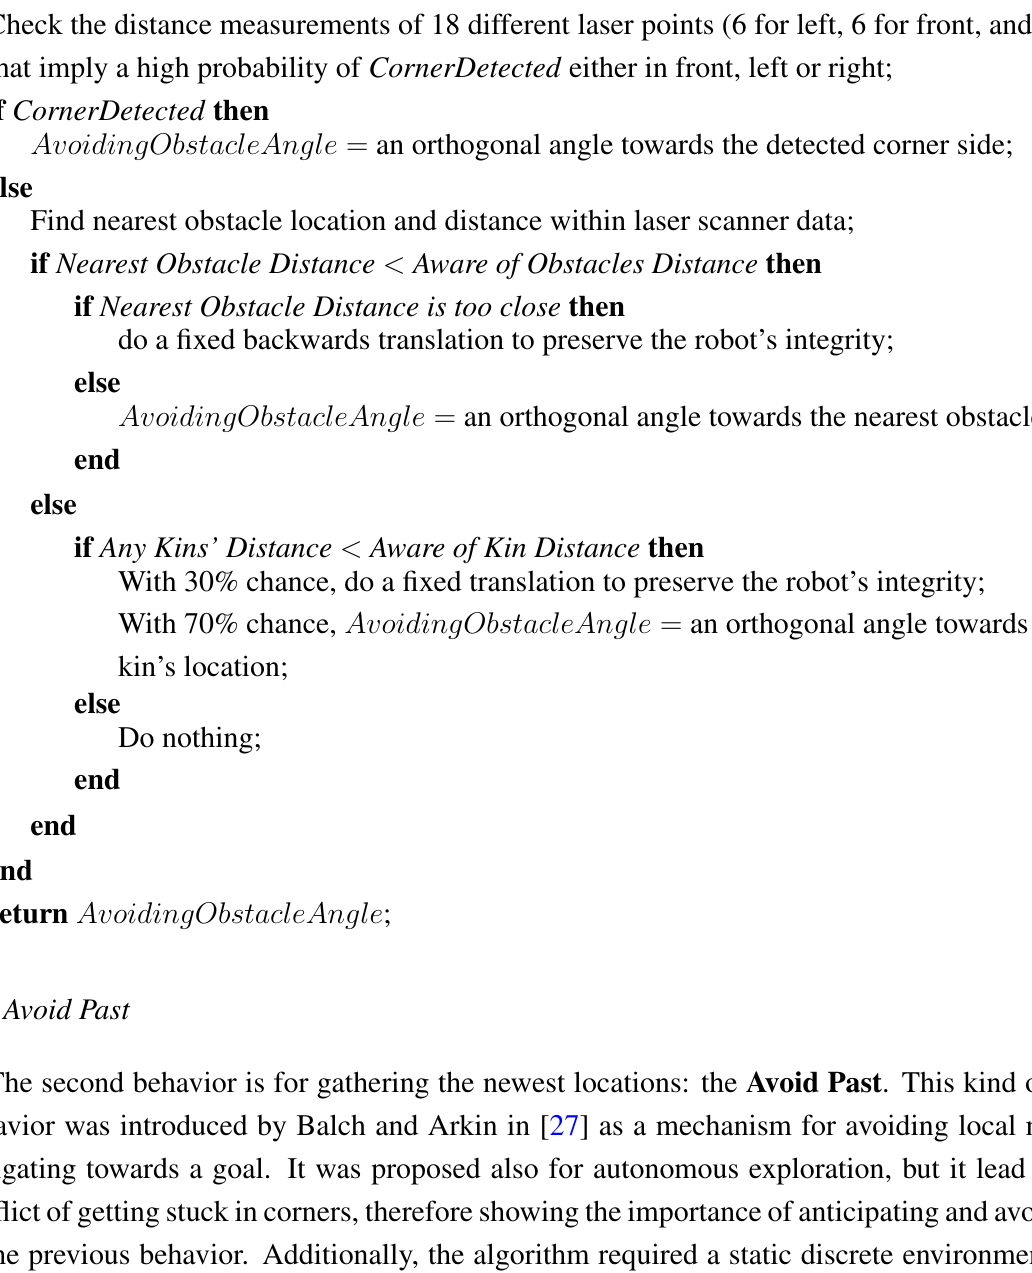
Algorithm 1. Avoid Obstacles